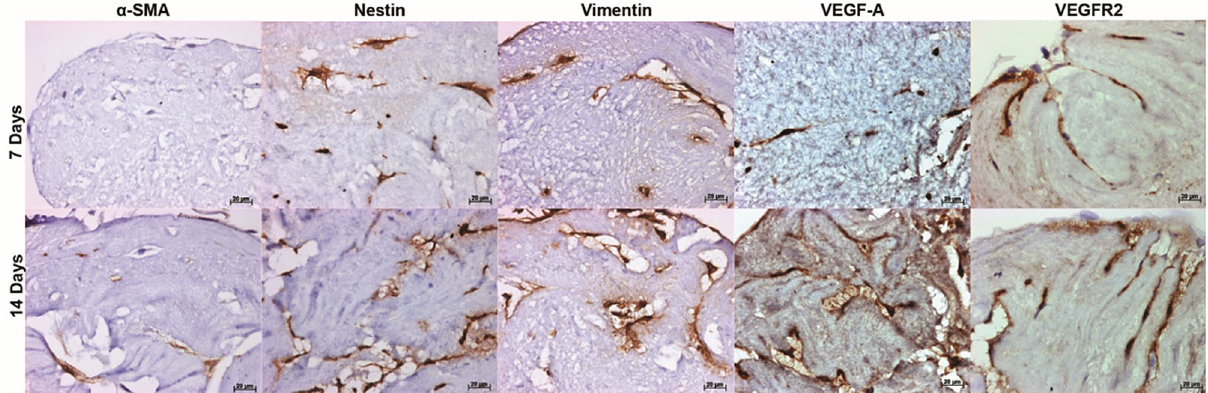
Figure 8. Gene expression following recellularisation of the decellularised pulp scaffold. Representative images of immunohistochemical labelled tissues revealed a positive immunoreactivity against nestin, vimentin, VEGF-A, and VEGFR-2 positive cells at 7 and 14 days culture. α-SMA was weakly stained at day 7 with an increase in staining intensity at day 14. α-SMA alpha smooth muscle actin, VEGF-A vascular endothelial growth factor-A, VEGFR-2 vascular endothelial growth factor receptor 2. Scale bars are at 20